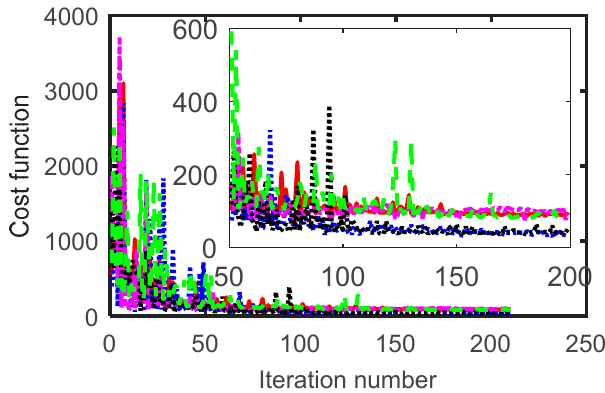
Figure 4. Cost function at different iteration number of the optimization technique.